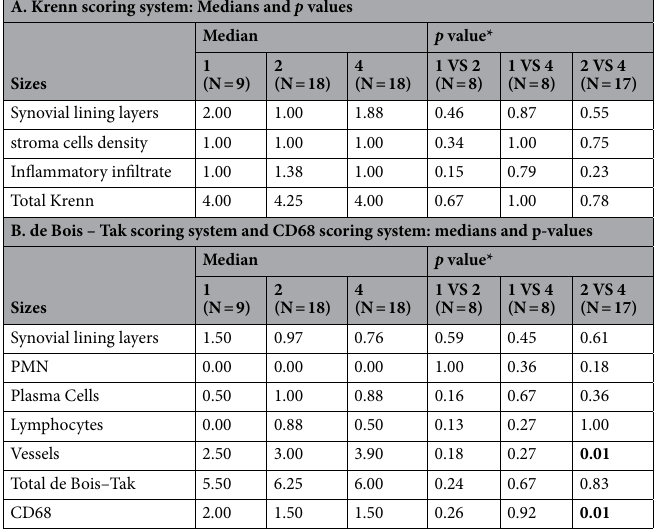
Table 1. intra-rater agreements according to size of biopsy forceps. * P value significant when less than 0.05/3 = 0.017. Significant values are in